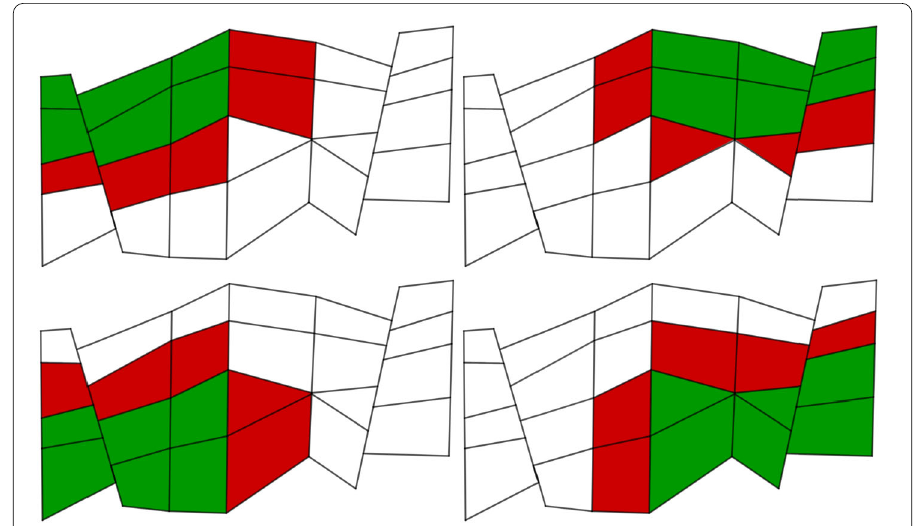
Figure 2 An illustrative example of 4-way mesh partitioning. The interior cells of each of the four subdomains are colored green, while ghost cells are colored